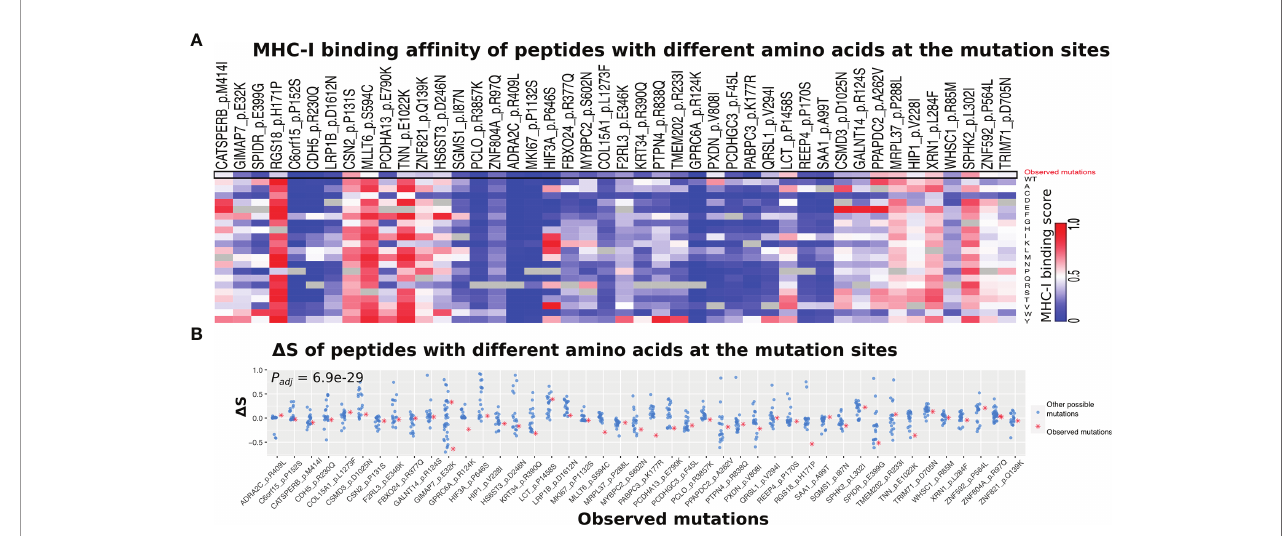
FIGURE 6 | Comparison of MHC-I binding alterations between observed and other possible amino acid changes. (A) Heatmap showing a list of 46 somatic mutations that derive neoantigen with signi fi cantly lower D S using the self HLA genotype than non-self HLA genotypes. The HLA genotypes of melanoma patients that do not have a speci fi c mutation were selected as non-self. (B) The observed amino acid changes (red dots) tend to have lower D S than those unobserved ones (other 18 possible amino acid changes) at the same position. The P adj -value was calculated by the ANOVA test and adjusted for multiple testing by the Benjamini – Hochberg